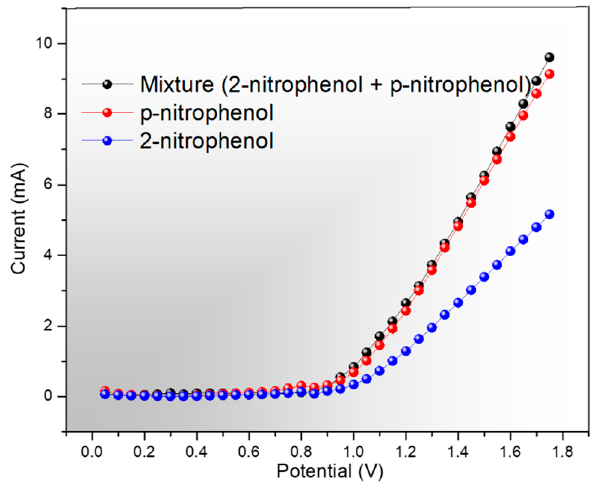
Figure 9. Selectivity against 2-nitrophenol (I–V response on individual analyte and mixture of 2-nitrophenol and p -nitrophenol. Table 1. Comparison of analytical parameters for detection of p -NP over various modified electrodes.